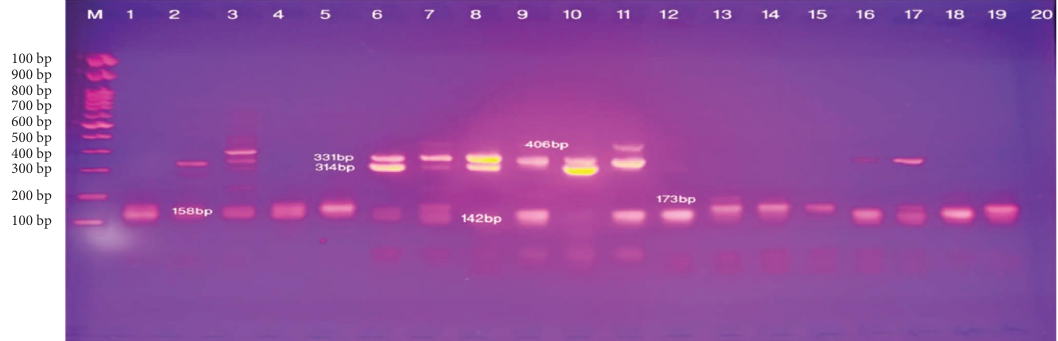
Figure 7 : Shows a multiplex PCR assay to identify the S. aureus resistance genes ermB (142bp), tet K (158bp), blaZ (173bp), mecA (314bp), mecA (331bp), and tet M (406bp).Marker 100